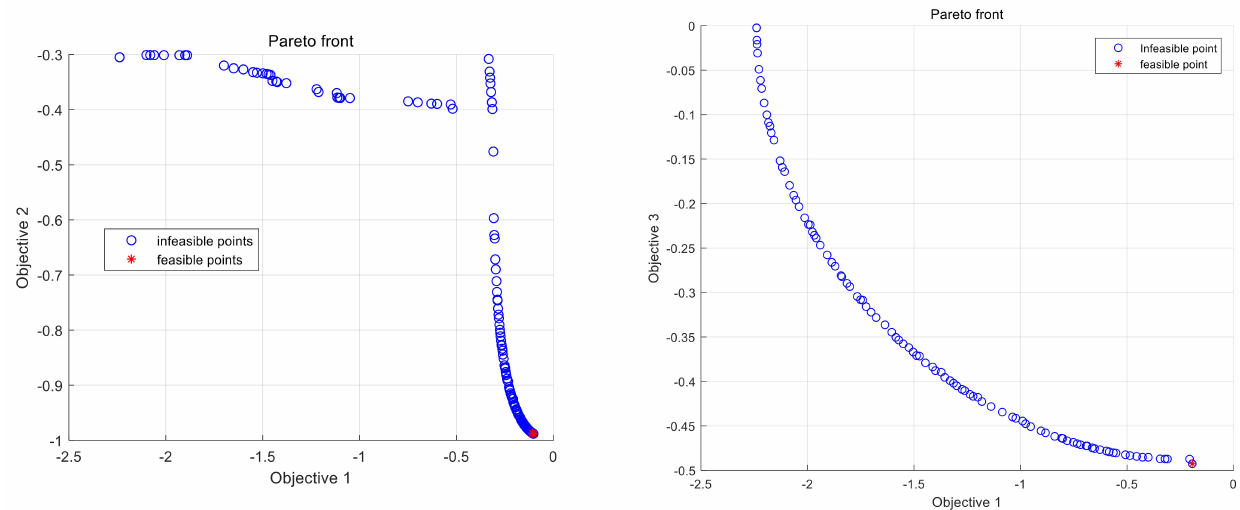
Figure 2. Pareto frontier for the KMCGO method on problem G8 in the first iteration.